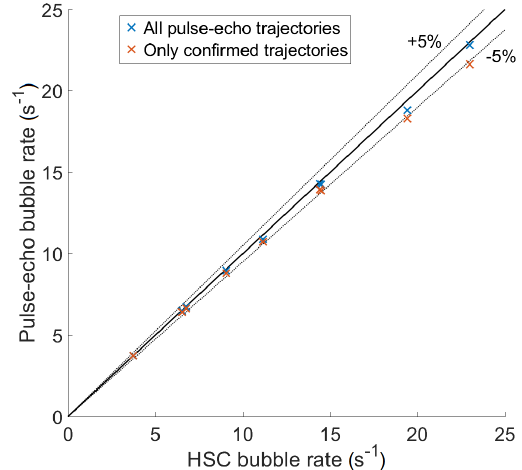
Figure 7. Comparison of the number of bubbles passing the measurement volume as measured by the pulse-echo with tracking and the